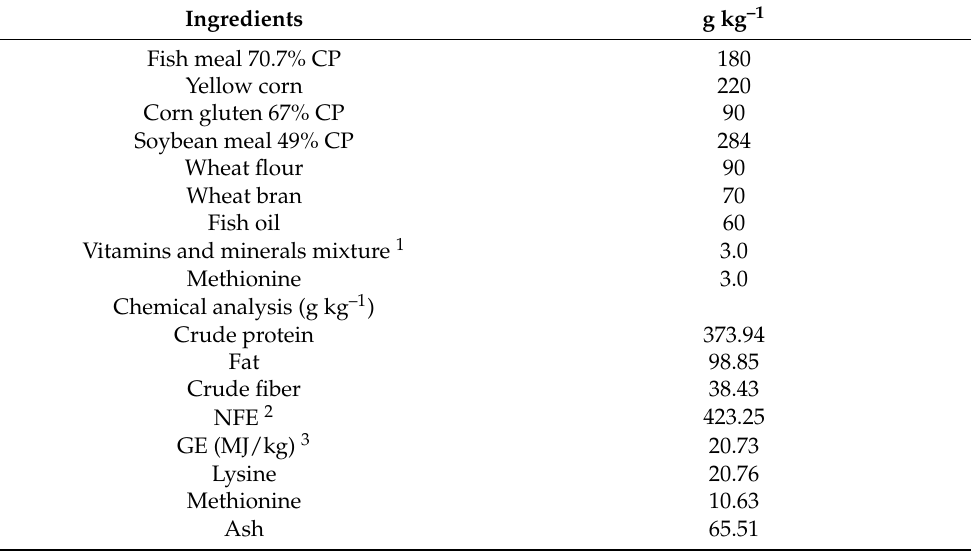
Table 1. The proximate chemical composition of the basal diet (g kg –1 , on dry matter